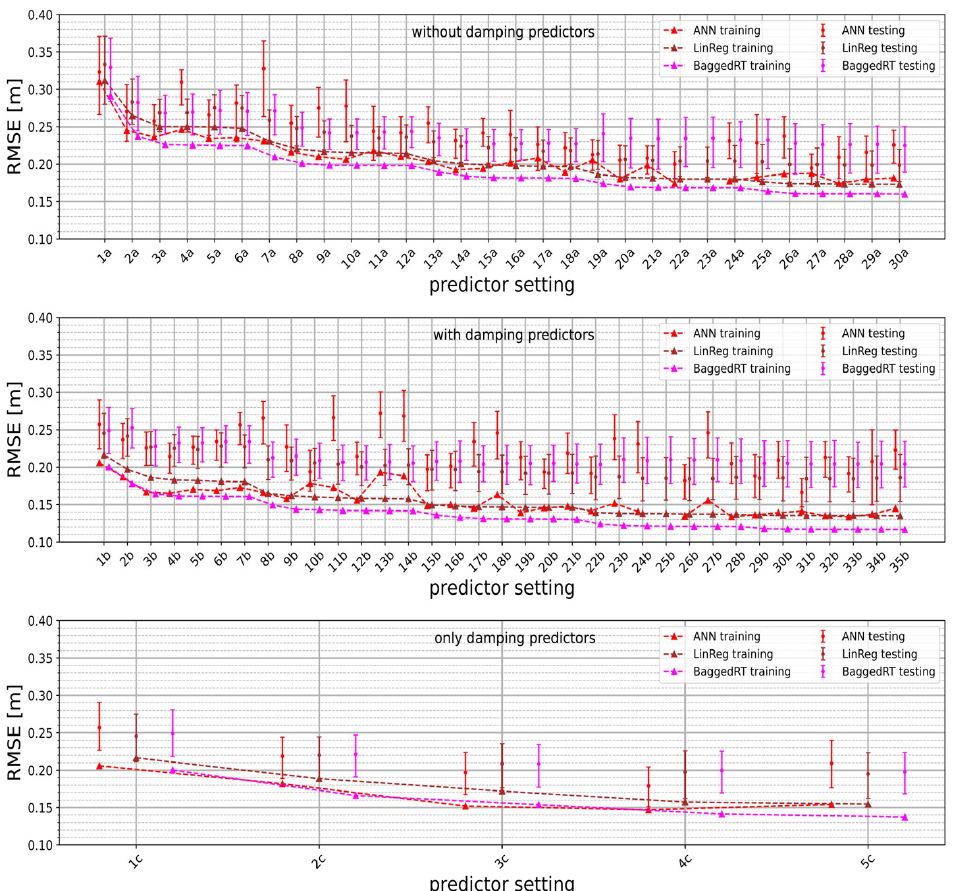
Figure 9. Accuracy obtained in training and testing for different models and predictor settings (top: setting a , middle: setting b , bottom: setting c ). Poor results of the ANN for settings 23 a and 25 b with training and testing RMSE of approximately 0.5m are not